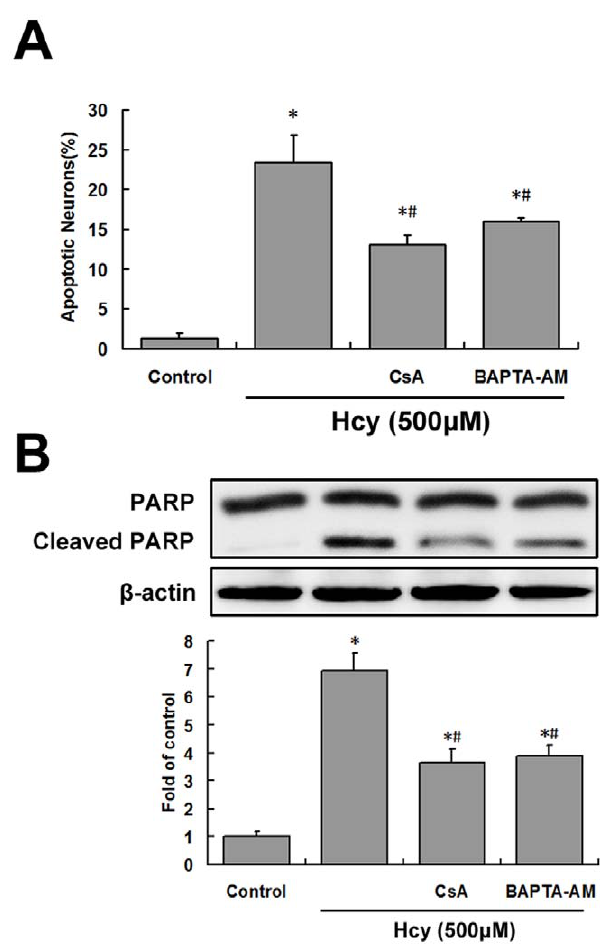
Figure 5. Inhibition of Hcy-induced apoptosis by a calcineurin inhibitor or intracellular Ca 2 + chelator. Cells were pretreated with 1 m M CsA or 10 m M BAPTA-AM for 30 min before treatment with 500 m M Hcy ( Hcy ) for 24 h. A, The level of apoptosis was determined by counting the number of neurons with apoptotic nuclei. Four randomly selected fields of Hoechst-stained cells were counted and the average percentage of apoptotic cells per total number of cells was determined. B, Cleaved PARP was studied by western blotting. Results are expressed as the mean 6 S.E.M. of three experiments. * P , 0.05 vs. control. # P , 0.05 vs. Hcy treatment